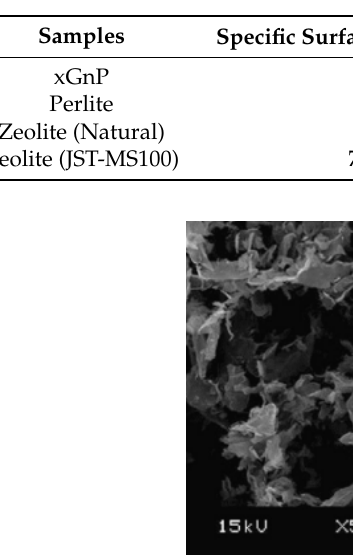
Table 1. The result of Brunauer Emmett Teller (BET) analysis.